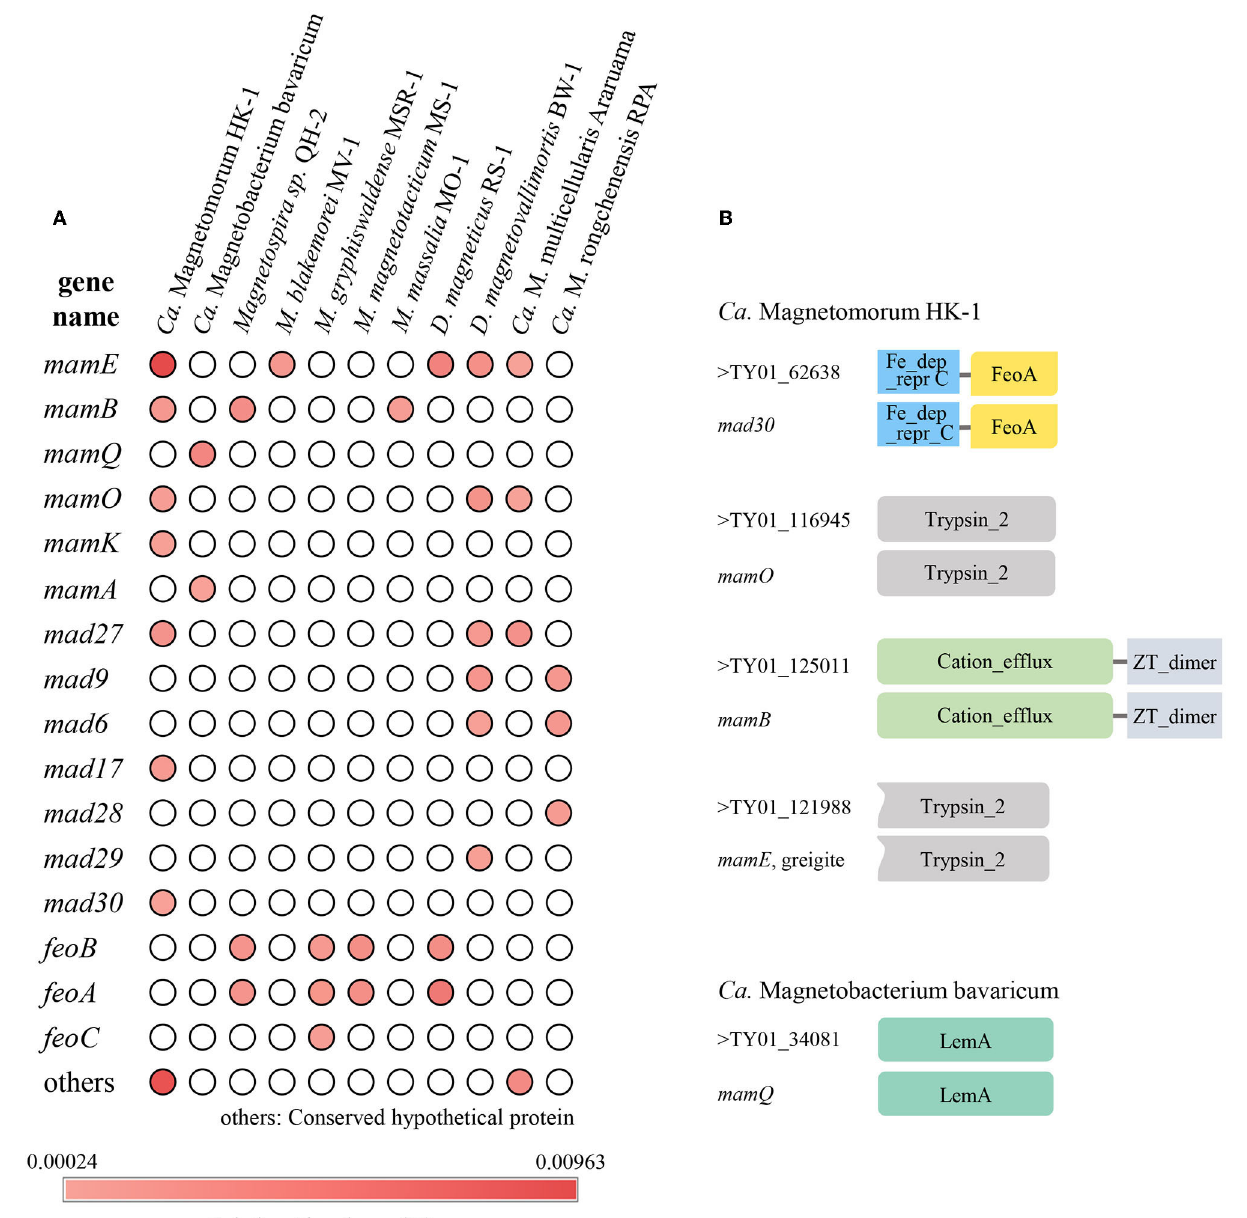
to Desulfobacterota , Nitrospirae , and the candidate phylum Omnitrophica (Kolinko et al., 2012; Chen et al., 2015; Li et al., 2015; Qian et al., 2019). Interestingly, both rock magnetic results and TEM analysis indicate that the abundance of BH components (bullet and elongated prisms) is ∼ 1.7 times higher than that of BS components (cuboctahedron and short prisms) ( Figures 3B,D